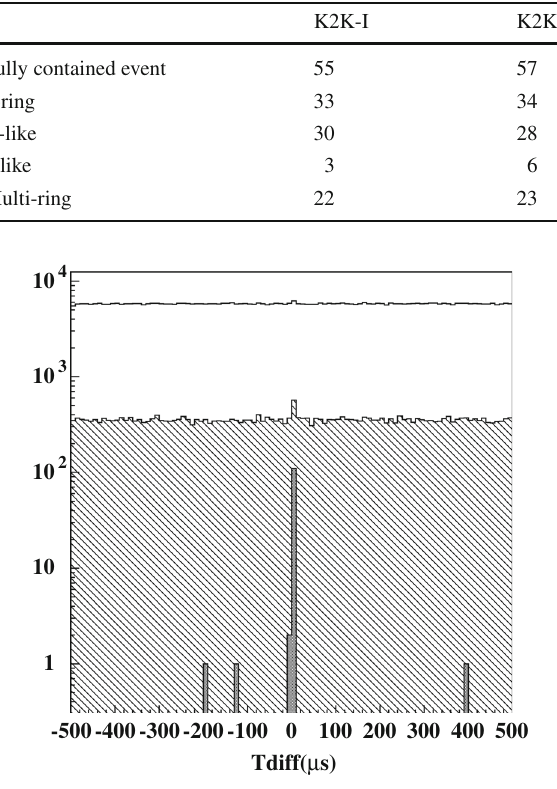
Fig. 27 Δ T distribution for each reduction steps. Clear, hatched and shaded histograms are after pre-activity cut, Evis > 30Mev cut and fiducial volume cut, respectively